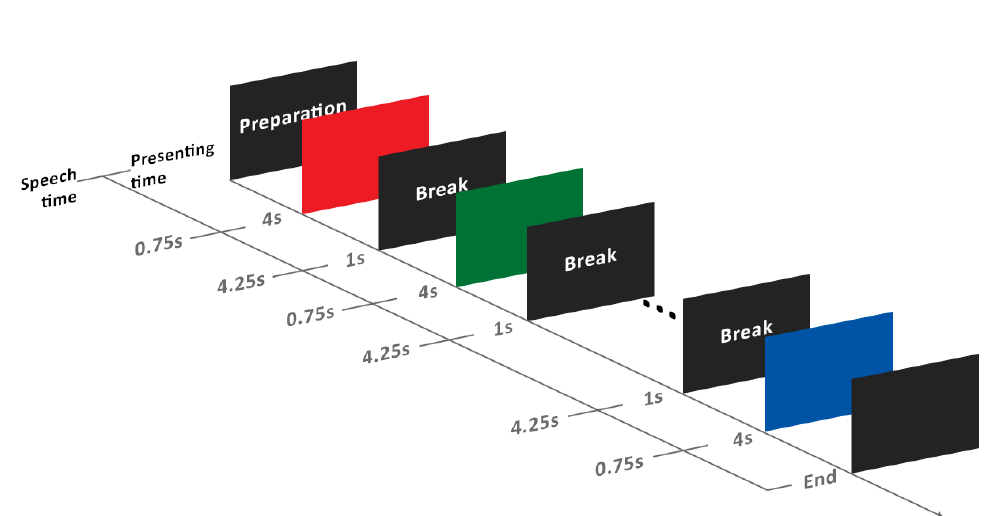
Figure 2. Protocol for electroencephalography (EEG) signal acquisition. On-screen presentation times and average speech times. Individual colours or colour names were displayed with breaks created by black colour on